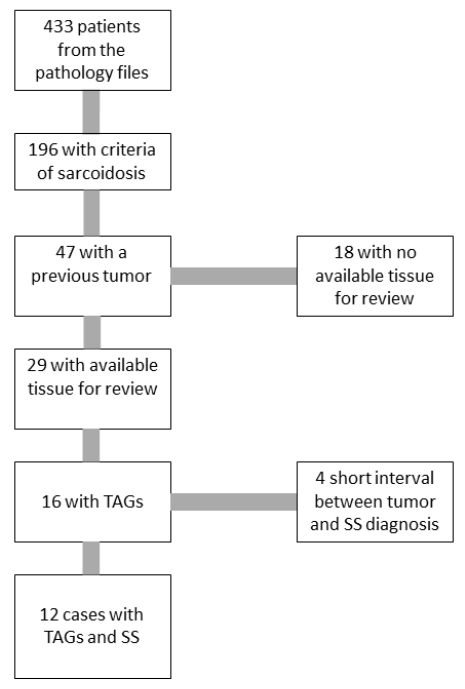
Figure 1. Flowchart showing the selected patients. The total of 433 was obtained from the pathol- ogy files after a search tool for cross-queries with words such as “mediastinal”, “lymph node”, “pulmonary”, “granuloma”, “sarcoidosis”, or “sarcoid”. TAGs—tumor-associated granulomas, SS—systemic sarcoidosis.